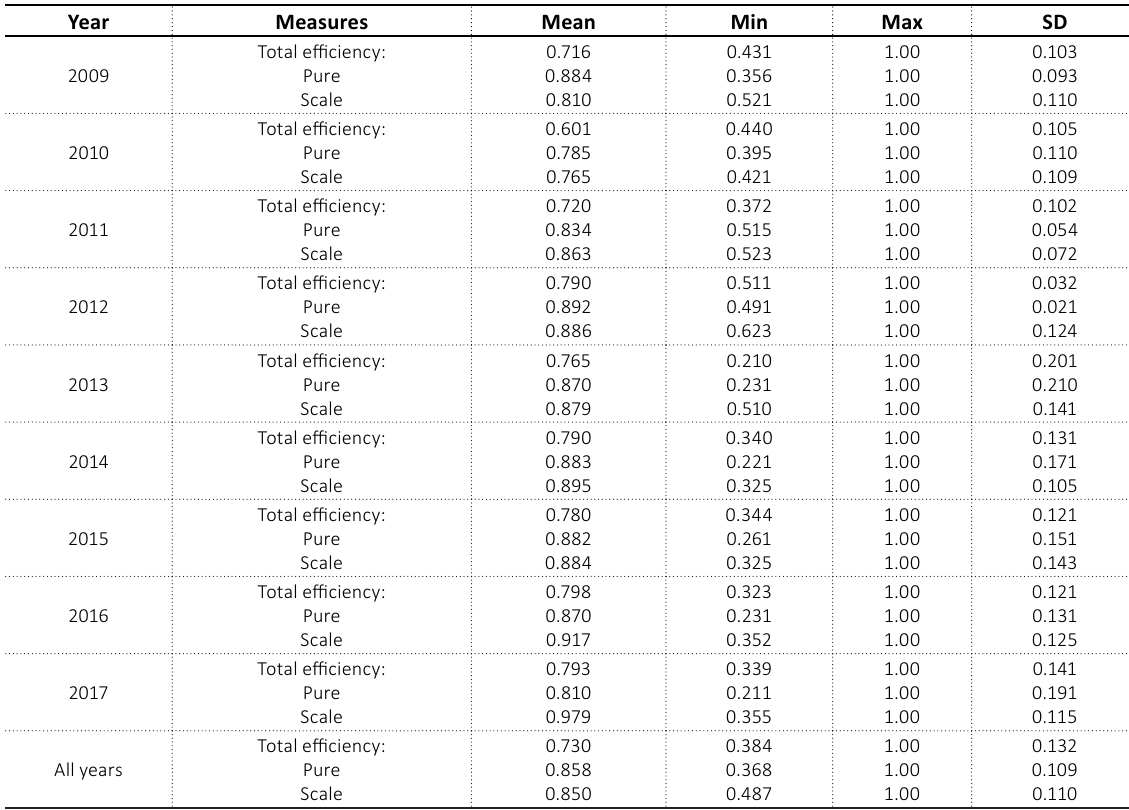
Table 8. Measures of efficiency of all banks after the